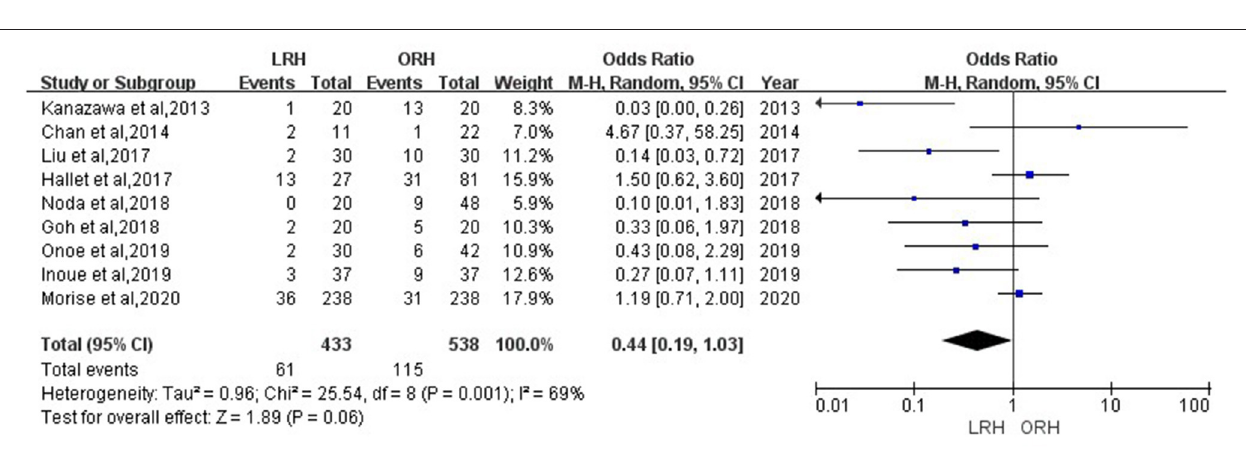
FIGURE 8 | Forest plots comparing overall postoperative complications rate between LRH group and ORH group.